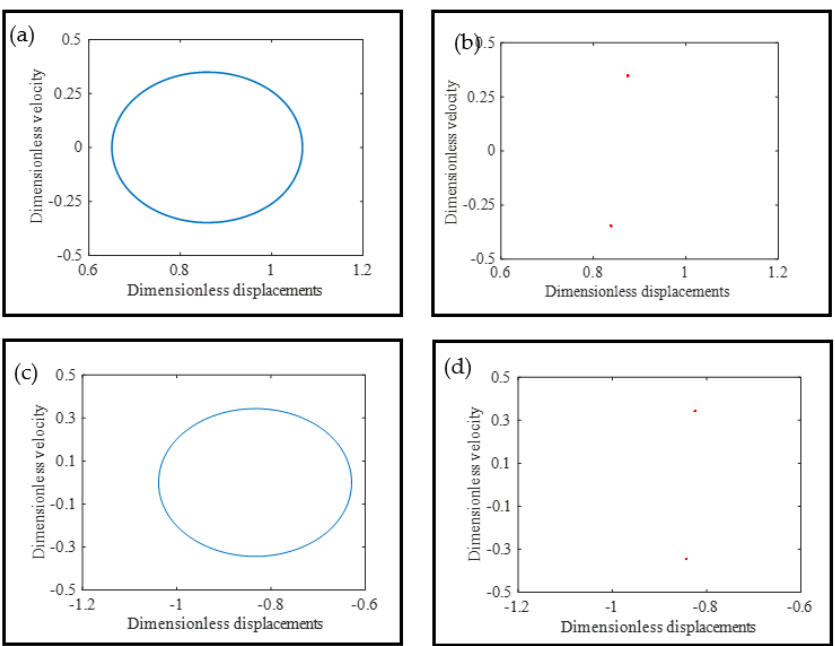
Figure 3. ( a ) The dimensionless relative displacement of the gear 1 and gear2, ( b ) the dimension- less relative displacement of the gear 1 and gear 3.